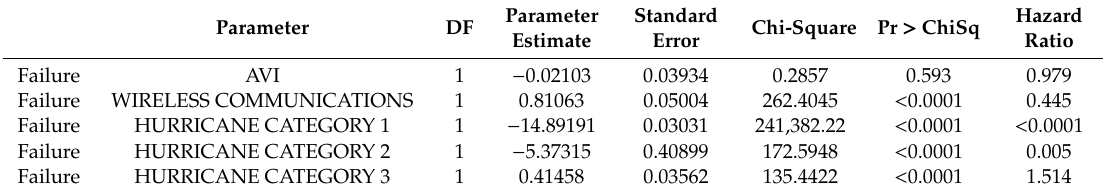
Table 5. Maximum likelihood estimates (vehicle detection